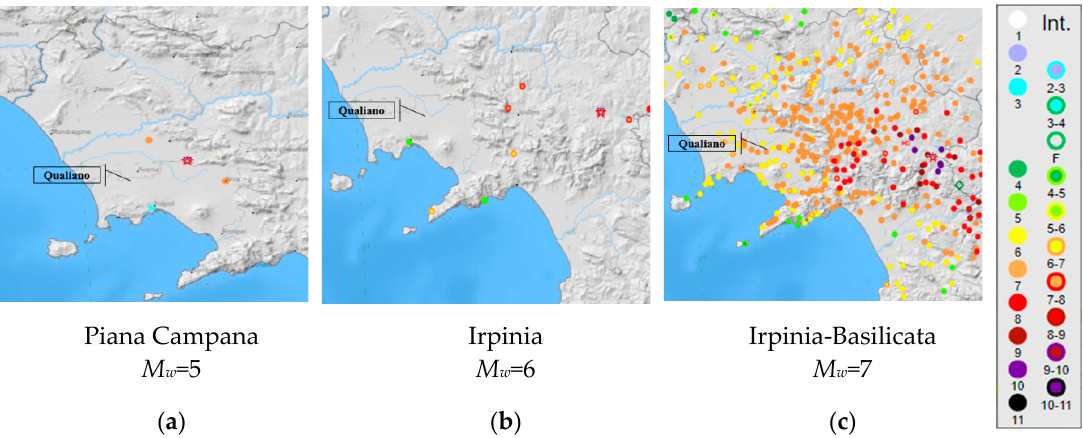
Figure 8. Historical earthquakes selected for the case study area [30]. ( a ) Piana Campana; ( b ) Irpinia; ( c ) Irpinia-Basilicata.